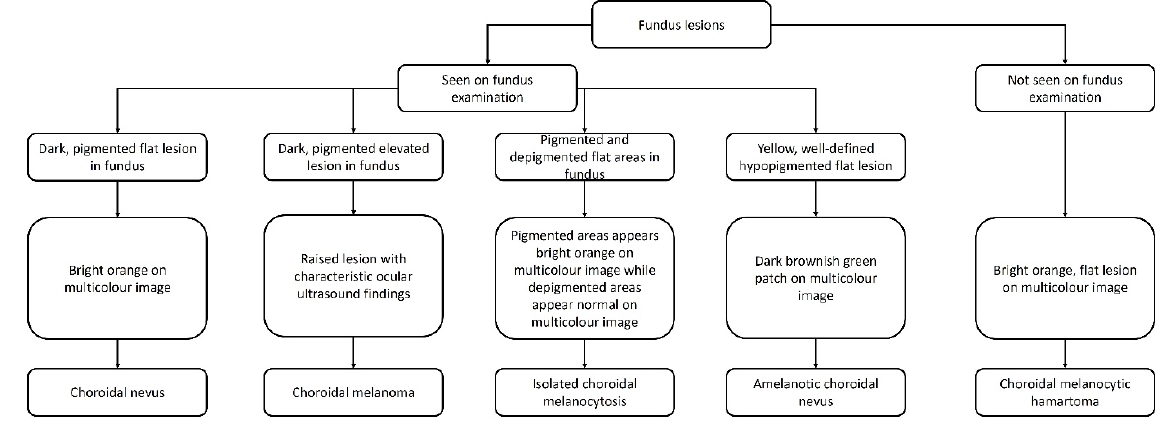
Figure 3. Flow chart depicting the clinical and imaging findings of different differential diagnosis. Table 1. Comparison between the differential diagnoses.